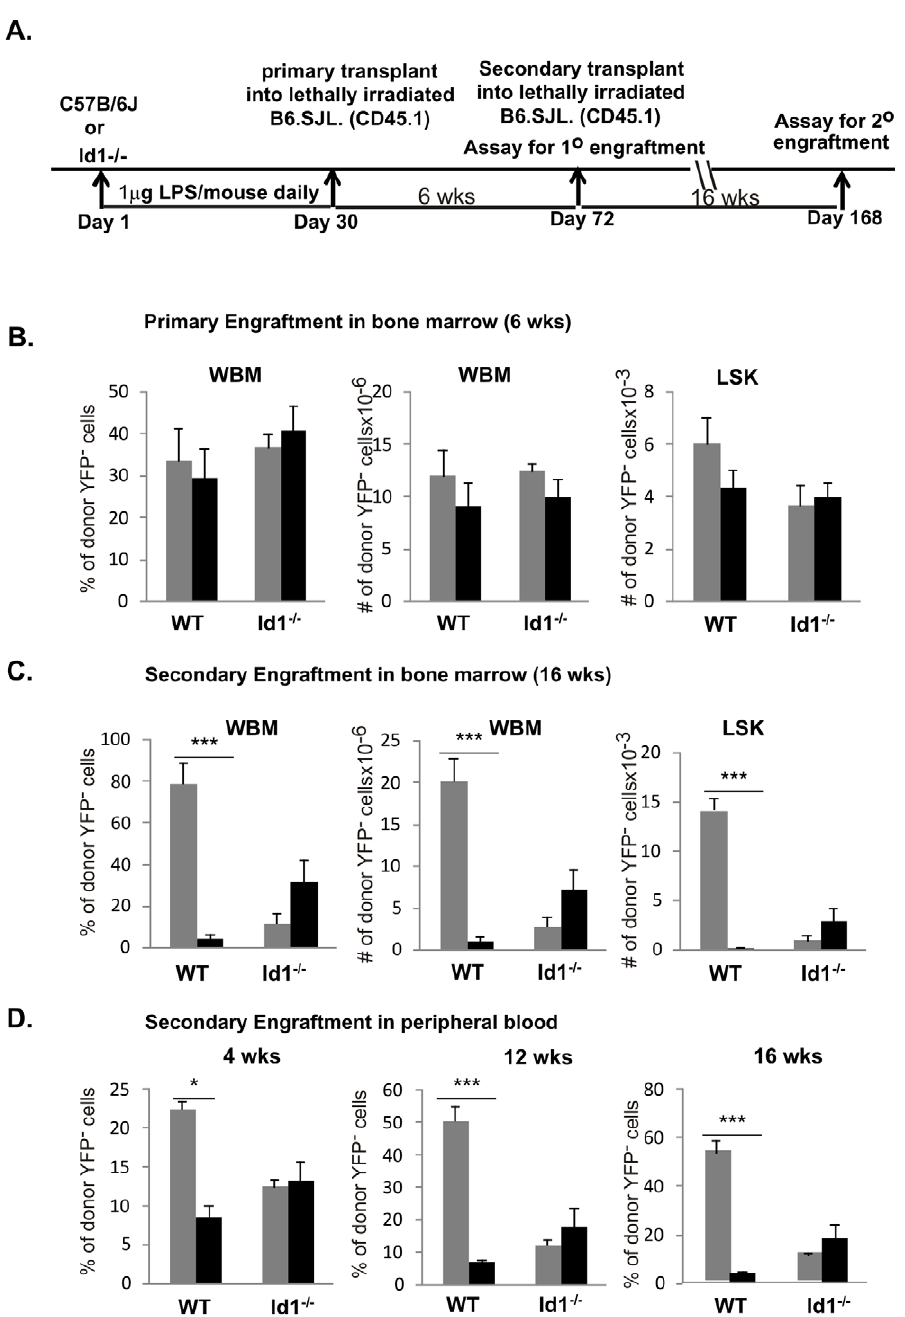
Figure 4. Competitive repopulation assay of HSC activity. (A) Experimental scheme. Lethally irradiated B6.CD45.1 recipients were transplanted with 1000 tester LSK from WT or Id1 2 / 2 mice untreated and treated with a daily dose of 1 m g LPS for 30 days together with 1000 competitor LSK from ROSA26-stop-YFP/ROSA26-CreERT2 mice exposed to tamoxifen as described in the methods. Actions taken during the course of 168 days are indicated. (B) Analysis of primary engraftment in the bone marrow of recipients of LPS treated (black bar) and untreated (grey bar) donor LSK cells. Six weeks post transplant, mice were sacrificed and whole bone marrow (WBM) cells were collected. Donor engraftment in WBM and LSK populations were analyzed by staining with antibodies against CD45.2 donor-specific marker and determination of YFP fluorescence in CD45.2 + cells. Average percentages or numbers of donor-derived YFP negative cells are shown with SEM. (C) Analysis of secondary engraftment in the bone marrow. Pooled bone marrow from each cohort of primary recipients was transplanted into lethally irradiated recipient. Secondary recipients were sacrificed 16 weeks later. Bone marrow cells were interrogated as described for (B). (D) Analysis of peripheral blood from secondary recipients. Peripheral blood was taken 4, 12, and 16 weeks post secondary transplant. Engraftment of donor-derived YFP 2 cells is shown as average percentage with SEM. *** p , 0.001; *p , 0.05.